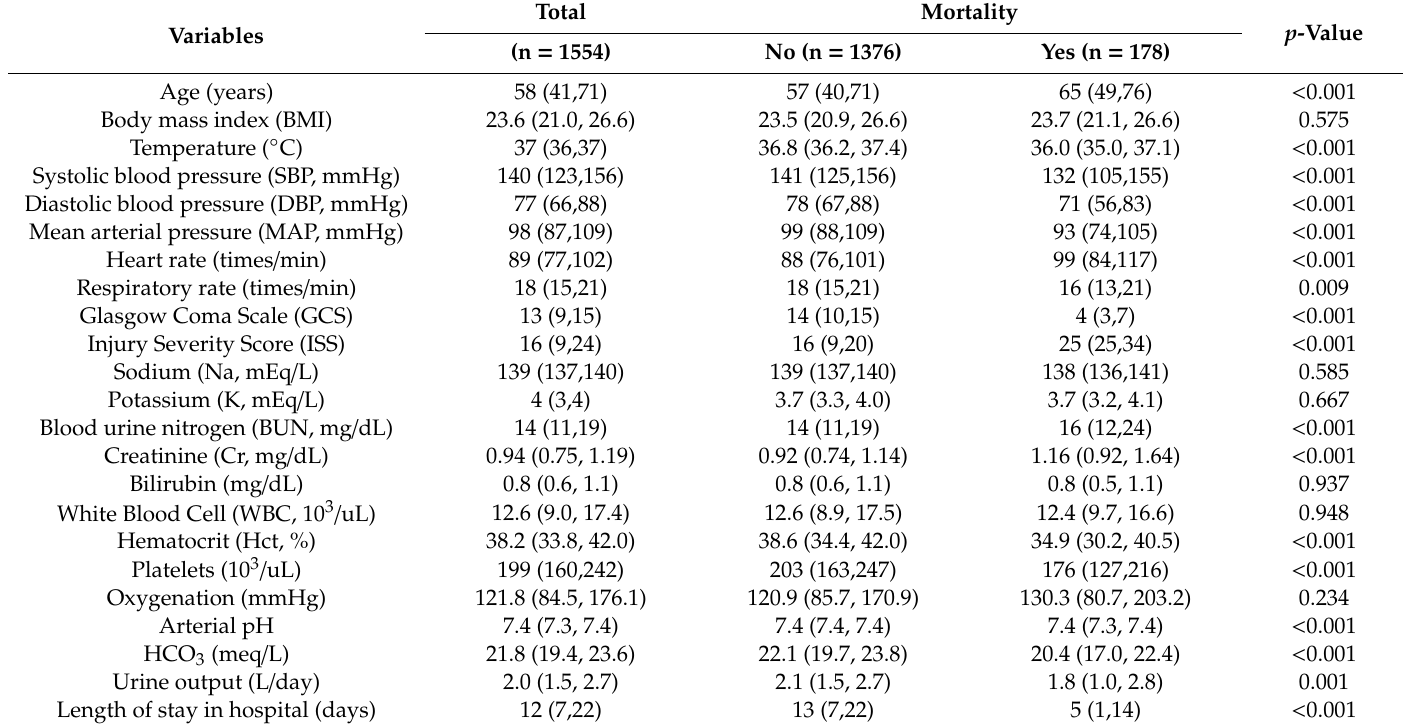
Table 2. Continuous variables of characteristics of critically ill trauma patients who died or